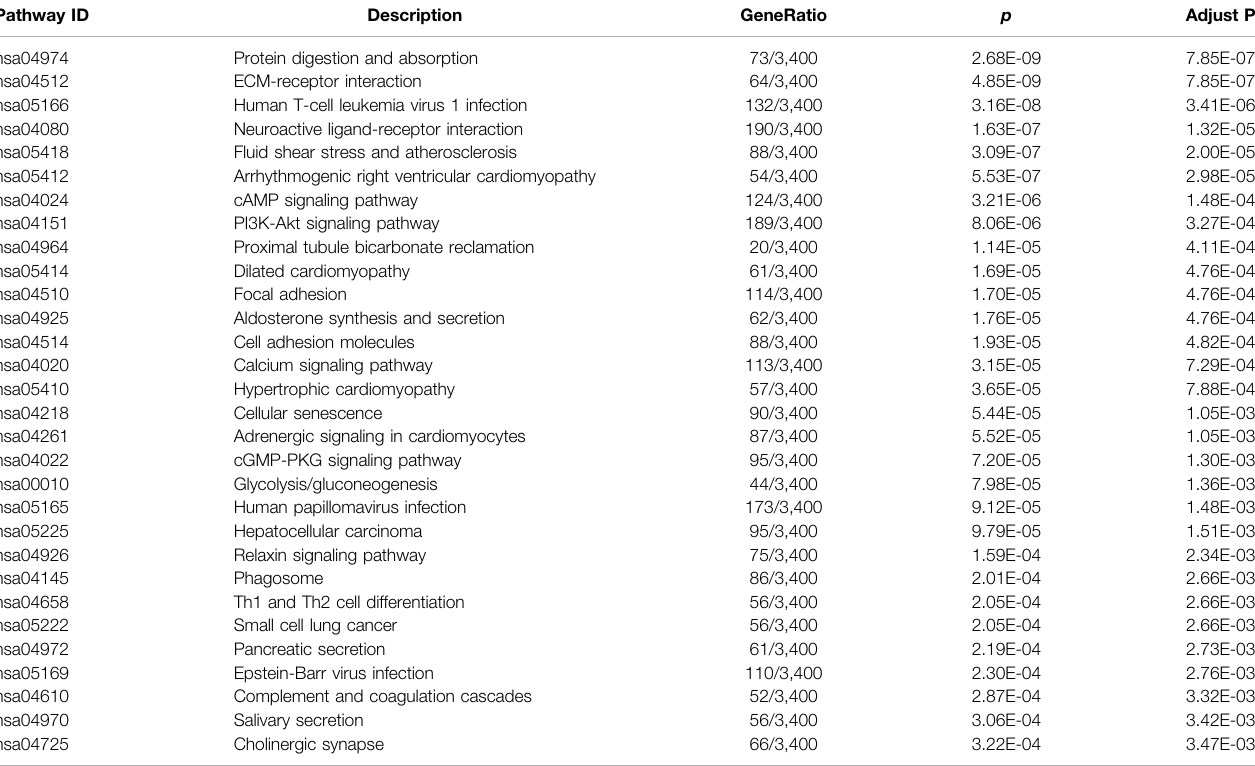
TABLE 3 | Top 30 most enriched KEGG pathway. Pathway